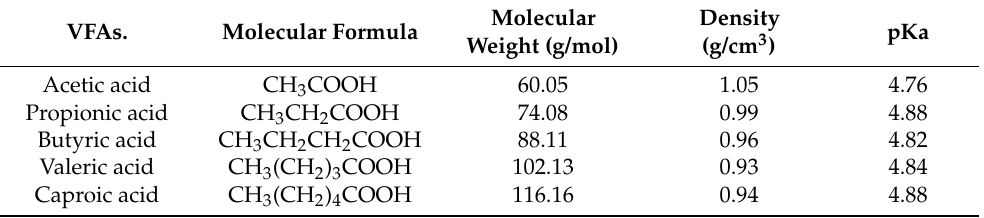
Table 2. VFAs properties